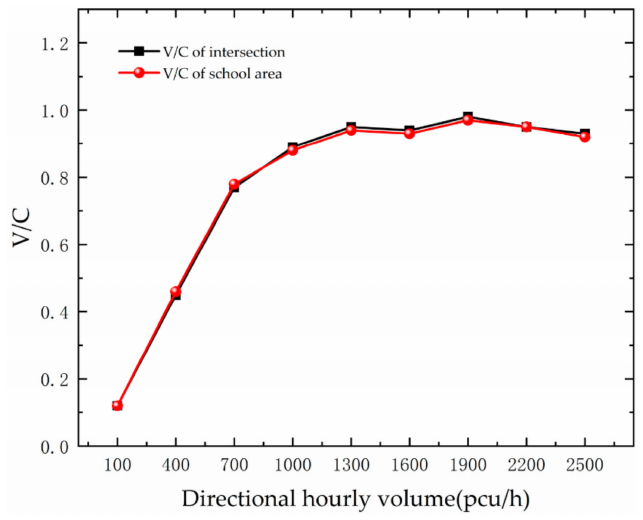
Figure 9. Variation trend of saturation with